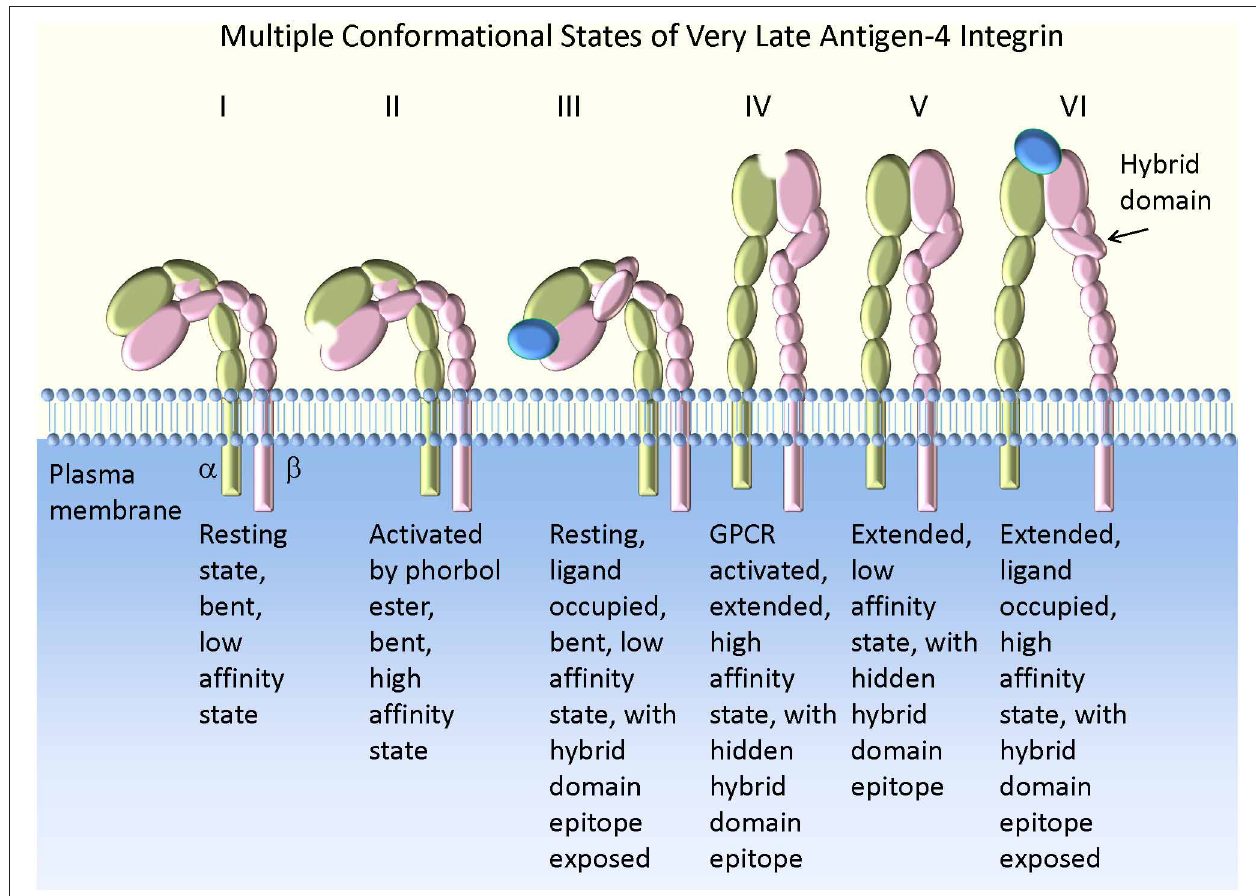
desensitization of the ligand binding affinity than relaxation of the conformation (Chigaev et al., 2007). Conformation V may also result from consecutive stimulation through G α i-coupled and G α s-coupled receptors (Chigaev et al., 2008). In suspension this translates into rapid cell aggregation that reaches a steady-state intermediate between resting (I) and G α i-coupled GPCR activated states (IV) [see Figure 7A in Chigaev et al. (2008)]. A low tether capture frequency and short tether duration was detected in the rolling assay ( Table 2 ) (see text for details). The ligand occupied and extended high affinity state (VI) was detected after G α i-coupled GPCR activation in the presence of ligand. The molecule affinity and extension were preserved by the use of a non-desensitizing GPCR mutant (Prossnitz, 1997; Chigaev et al., 2003a, 2007). This conformation results in the rapid formation of a large number of aggregates in cell suspension (Chigaev et al., 2008), with high tether capture frequency and long tether duration in the rolling assay ( Table 2 ). The exposure of the hybrid domain (LIBS) epitope can be also used to determine VLA-4 ligand binding affinity for unlabeled ligands (Chigaev et al., 2009; Njus et al.,